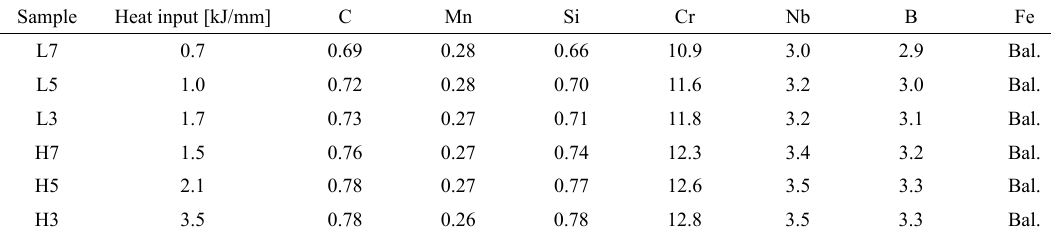
Table 2. Chemical composition of the weld metal (% by